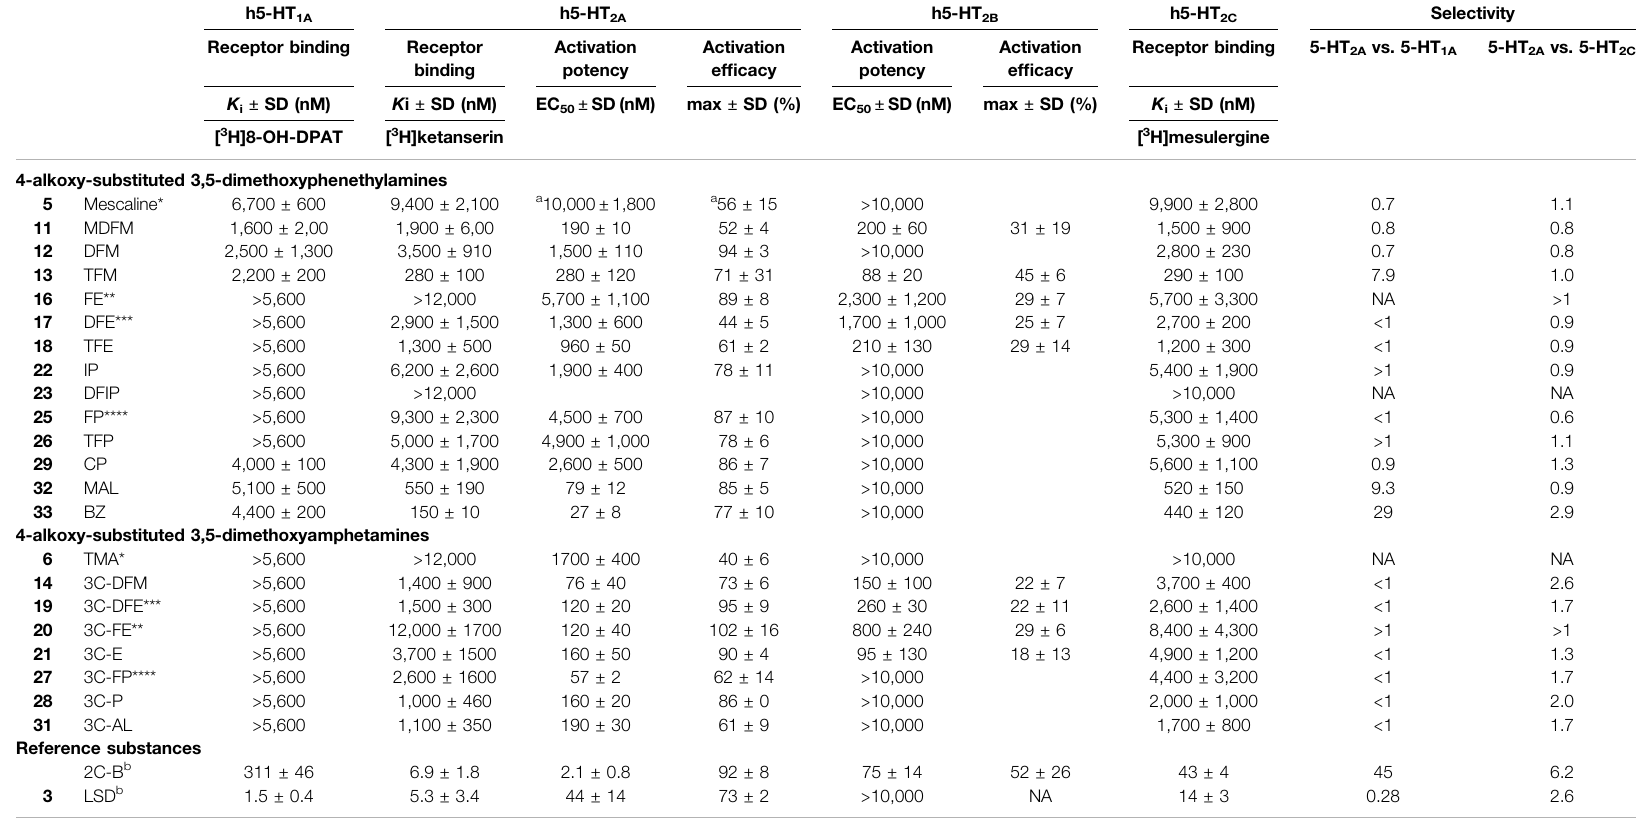
TABLE 1 | Serotonin receptor binding af fi nities and activation potencies of 4-alkoxy-substituted 3,5-dimethoxyphenethylamines and